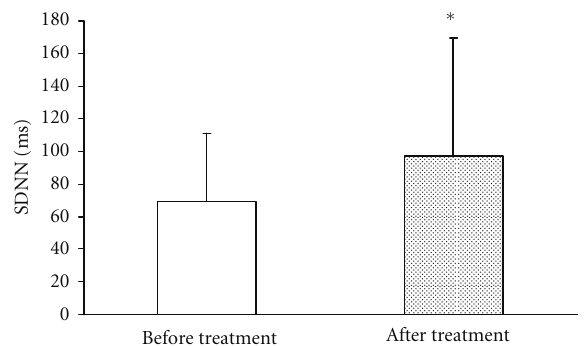
Figure 6: The VRS scores before and after treatment. Expression values are the mean and standard deviation, and the statistical di ff erence was detected by Wilcoxon Signed-Rank Test. Asterisk means that this group has statistical di ff erence with control group ( P < 0 .